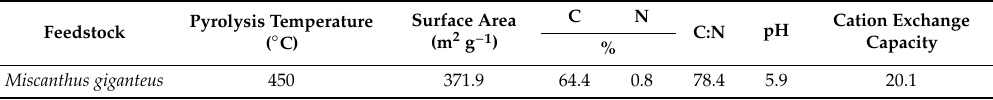
Table 1. Physical and chemical properties of the biochar used in the experiment.